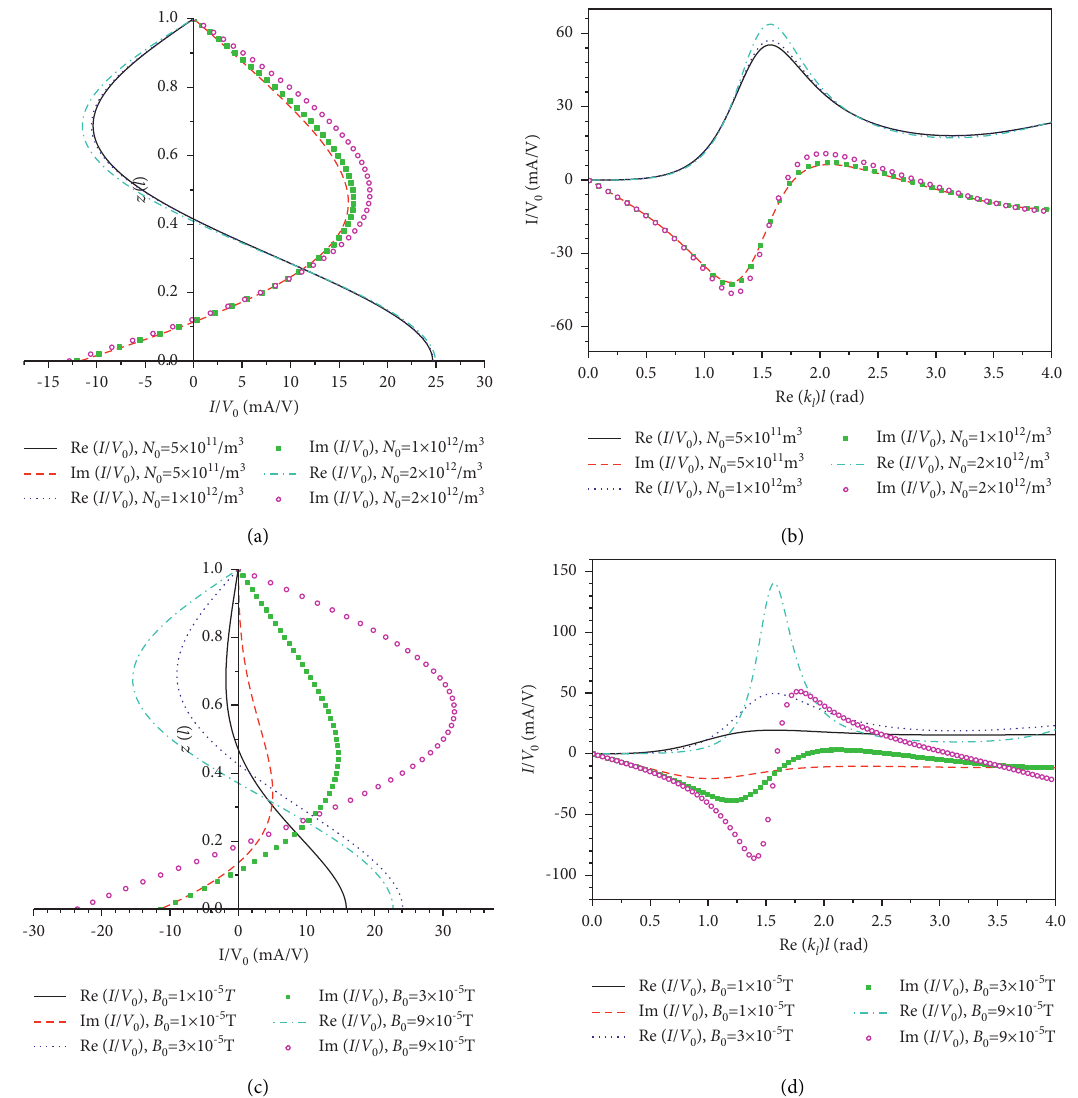
Figure 6: Real and imaginary parts of the normalized current on an insulated antenna in an anisotropic ionosphere for different electric densities and magnitudes of geomagnetic field. (a) Effects of electric densities versus z / l , (b) effects of electric densities versus Re ( k l ) l , (c) effects of geomagnetic field versus z / l , and (d) effects of geomagnetic field versus Re ( k l ) l